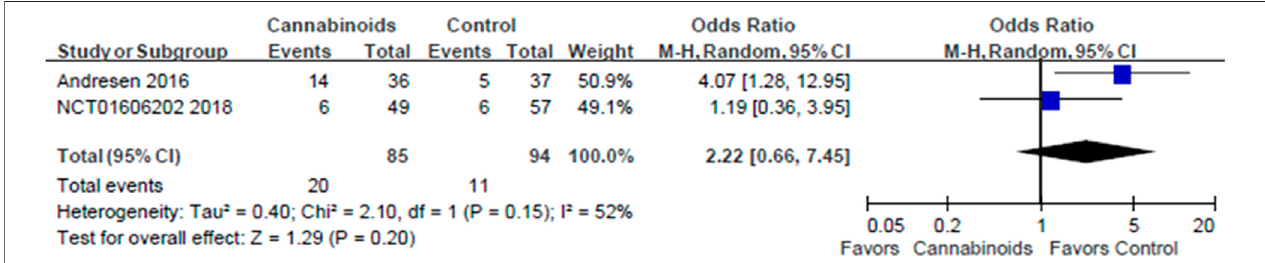
FIGURE 8 | Post hoc analysis comparing cannabinoids to placebo after excluding the study population with brachial plexus avulsion among the adverse events. Lower rate of adverse events is shown by the favored side of the